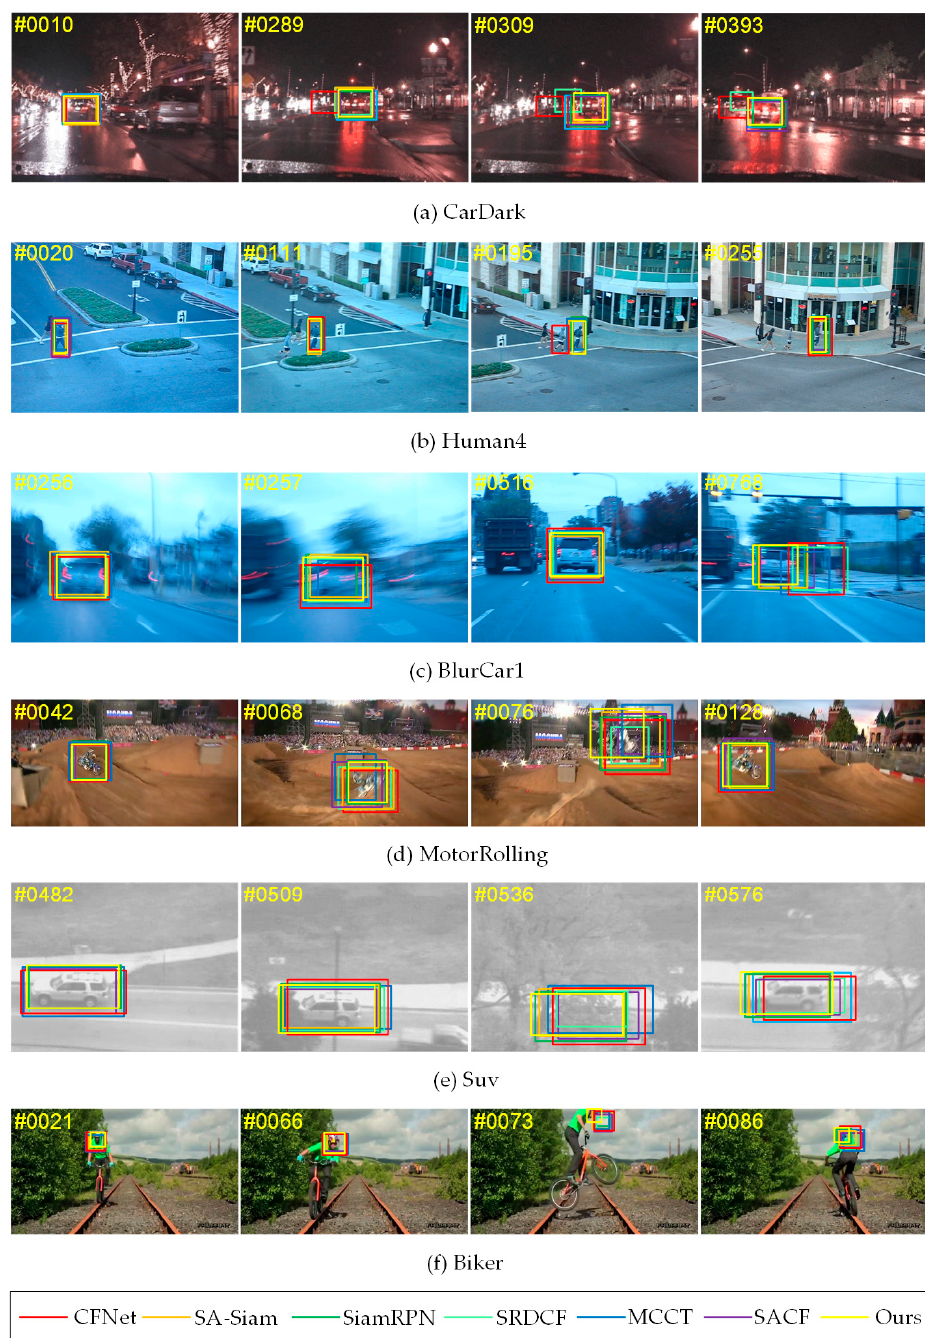
Figure 8. The tracking results of different object tracking algorithms for the testing